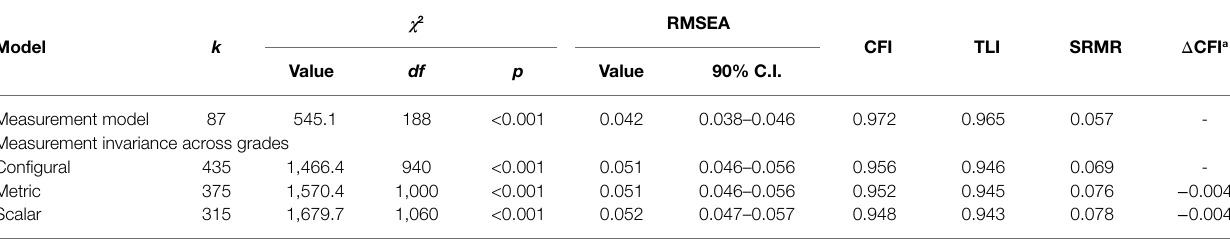
TABLE 2 | Fit statistics for the measurement model and measurement invariance models across grades.